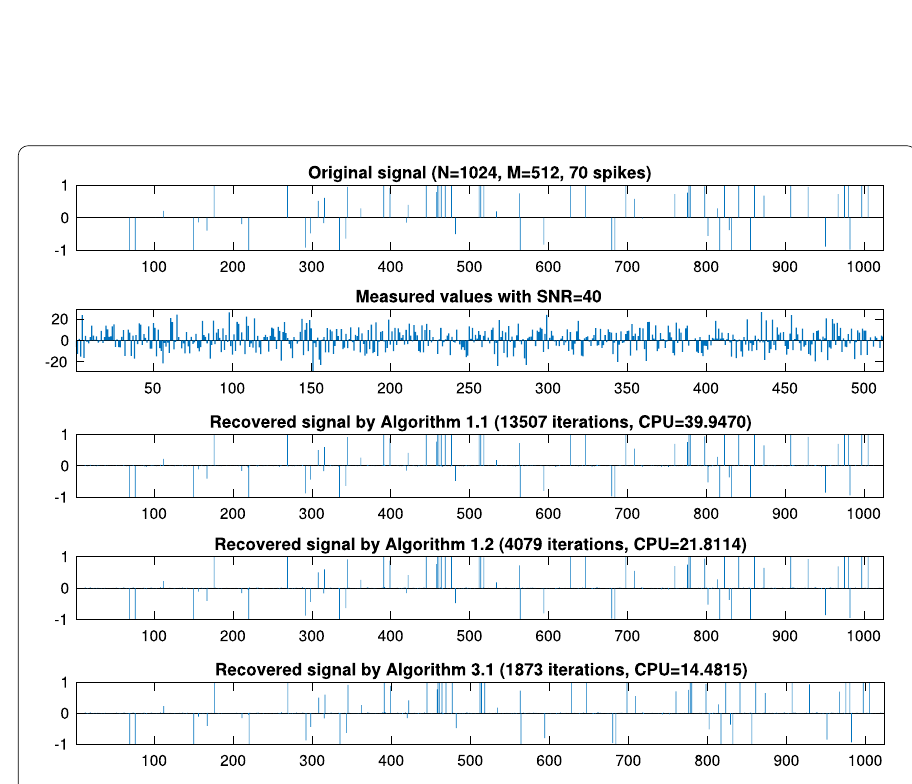
Figure 2 Original, observed, and recovered signals by Algorithms 1.1, 1.2, and 3.1,